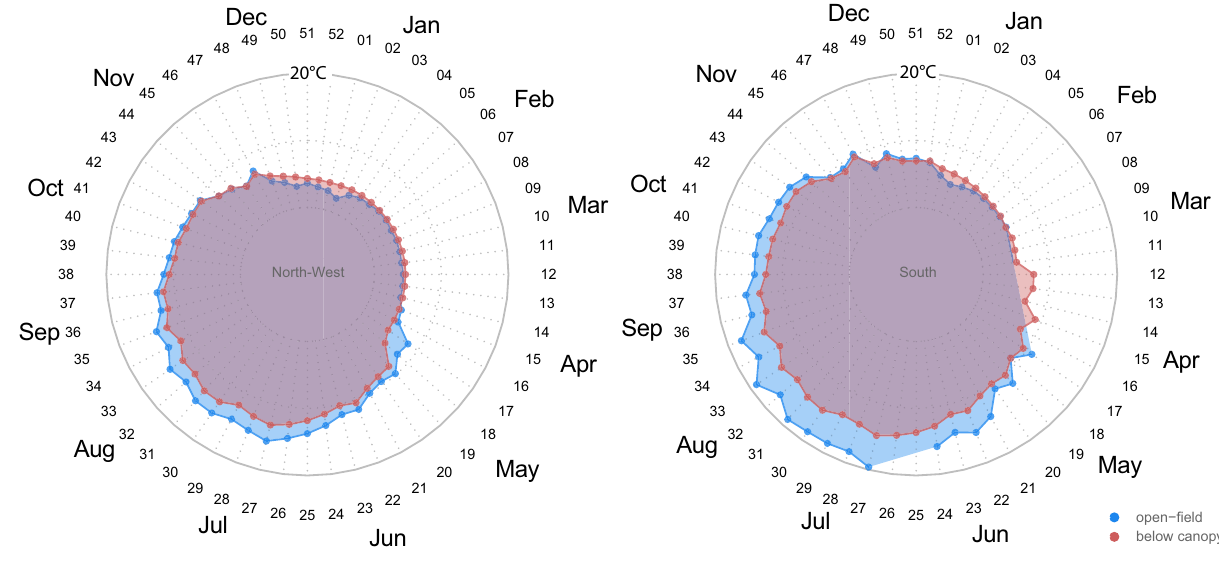
Figure 7. Average weekly soil temperature recorded in the open field (blue) and below the forest canopy (red) at the North-West (left) and South (right) aspect. Black numbers in the radar charts are the week number from the start of the year while gray numbers indicate the temperature (in °C).